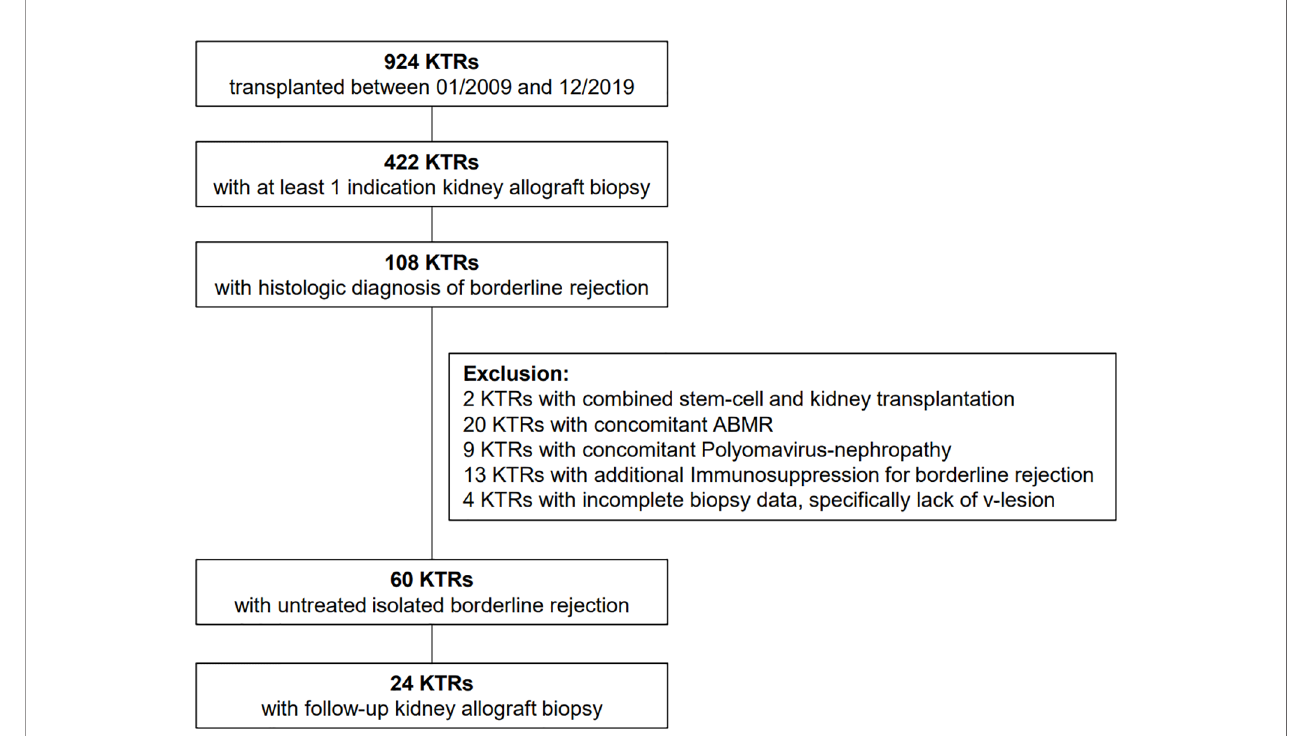
FIGURE 1 | Patient inclusion and exclusion